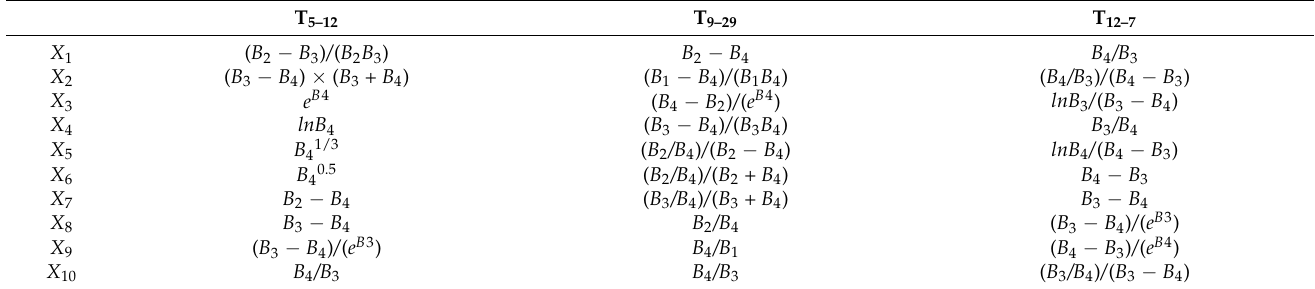
Table 4. Sensitive spectral indices of recognition for O. acutissima and R. pseudoacacia